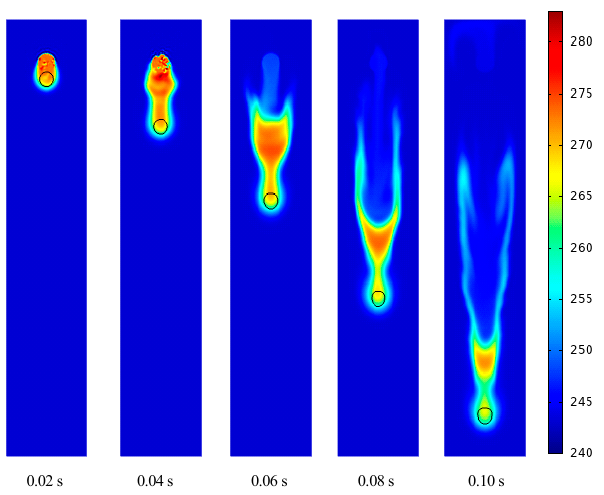
Figure 12. Temperature distribution of a free-falling water droplet in air at 243.15 K. During the water droplet falling in freezing temperatures, the viscosity of the water droplet varies with the decrease in temperature. Figures 13 and 14 show the viscosity of the water droplet falling in air at 263.15 K and 243.15 K, respectively. The water droplet is a whole round shape with a lower viscosity value at 0.02 s. Before landing on the bottom, the water droplet has a higher viscosity value of about 0.5 at 0.10 s. After landing on the bottom, the water droplet splits in two in the air at 263.15 K and 243.15 K. At 0.50 s, there are two of the same water droplets with semi-sphere shapes located on the bottom. 0.02 s 0.50 s Figure 13. Viscosity of the water droplet in air at 263.15K.